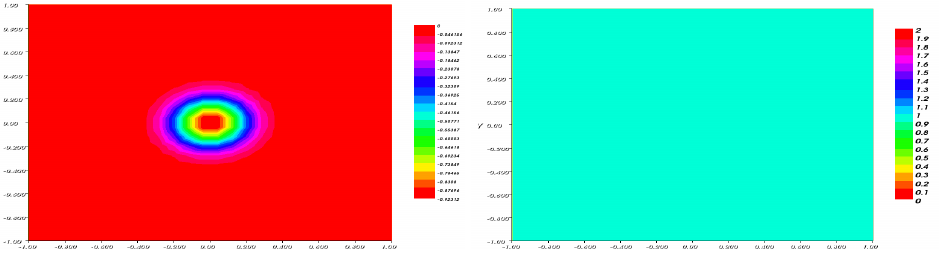
Figure 9. The fraction ϕ ( left ) and ψ ( right ) after T = 0.